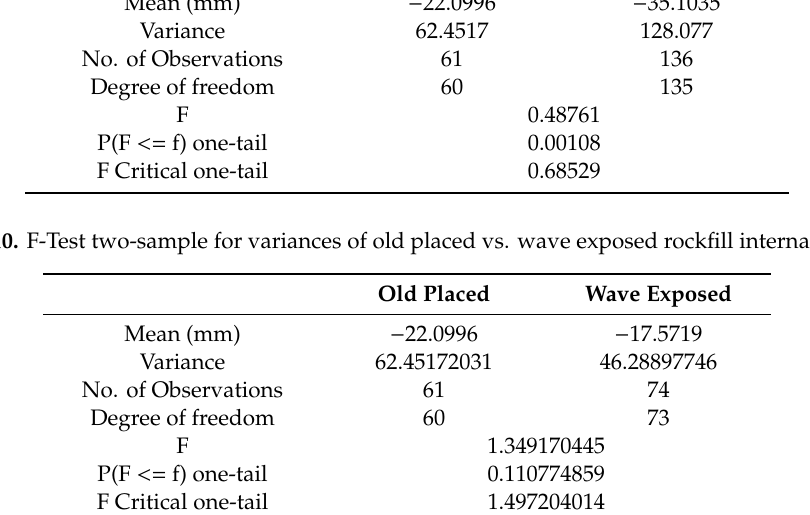
Table 9. F-Test two-sample for variances of old placed vs. freshly placed rockfill internal zones. Old Placed Freshly Placed